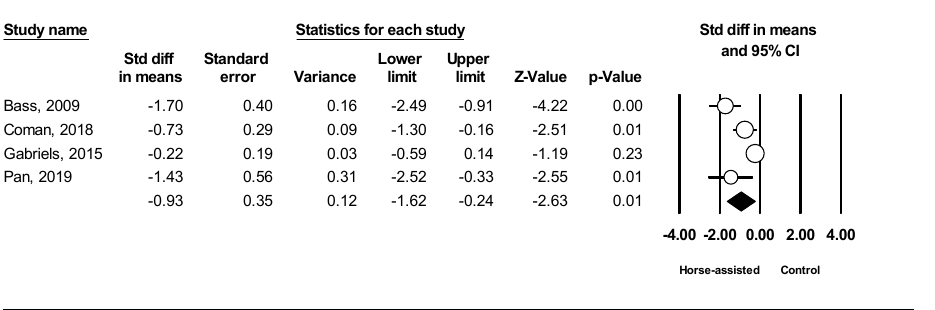
Figure 3. Forest plot showing the effects of horse-assisted therapy vs. control on social awareness [31,43,44,46].